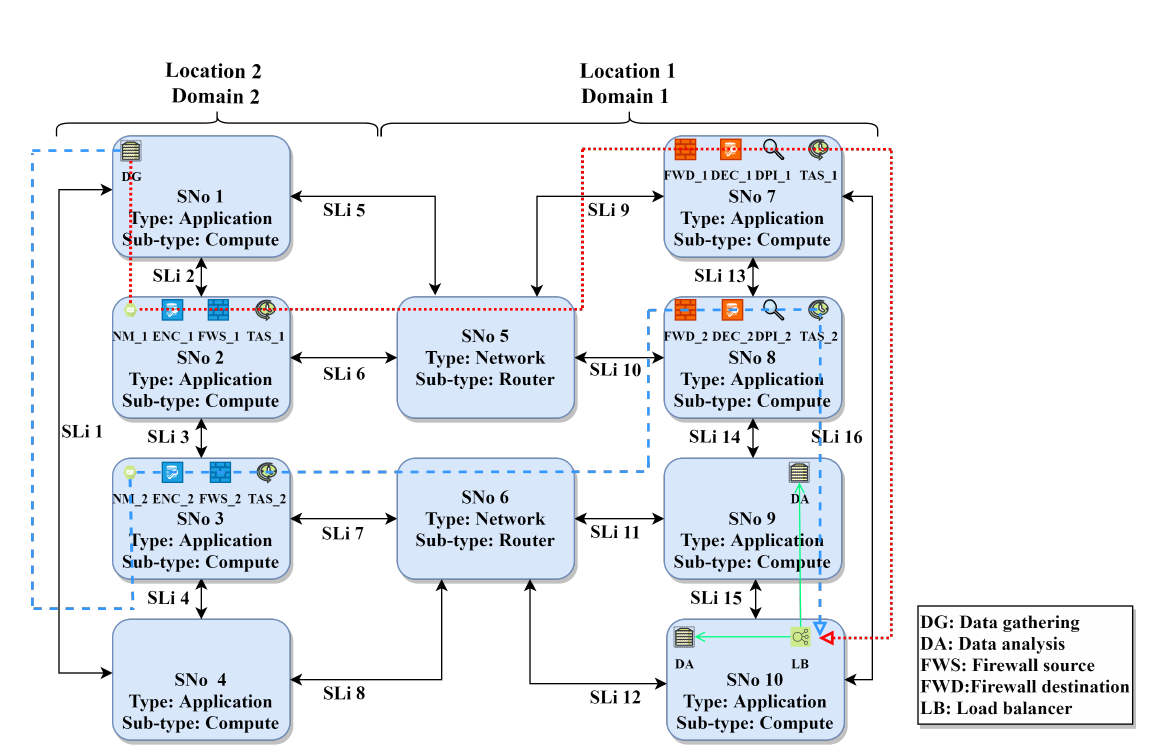
Figure 7. Embedding AR11 in the substrate